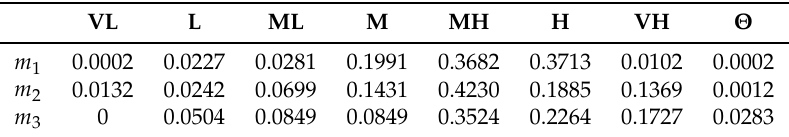
Table 7. The BPAs of bottom criteria after combination.